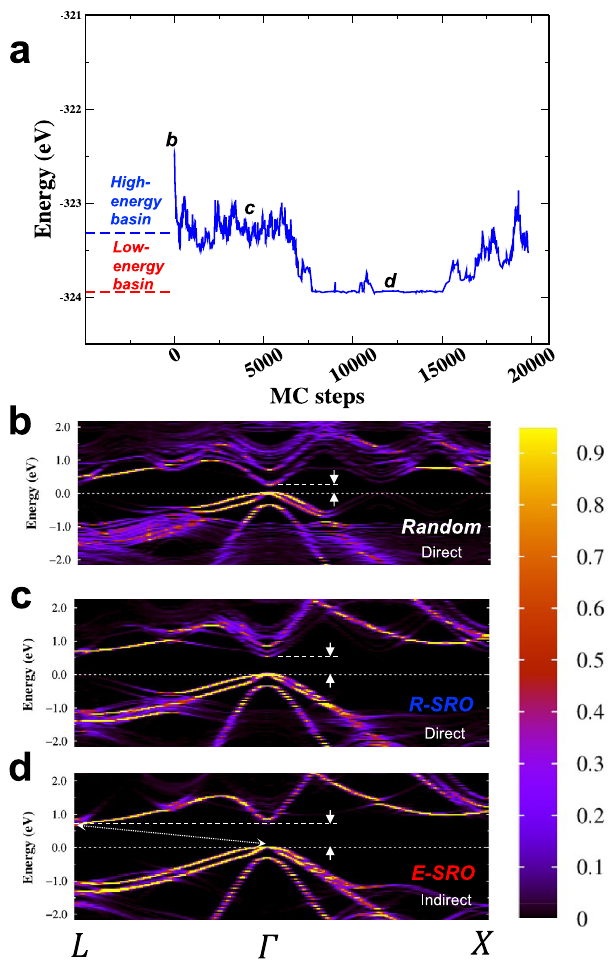
Fig. 4 Variation of the calculated electronic band structure with SRO in Si 0.125 Ge 0.625 Sn 0.25 . a Con fi gurations b – d are extracted from Monte Carlo trajectory 4 (see Fig. 1c). b A random distribution leads to a direct band gap at Γ of 0.25 eV. With R-SRO ( c ), the direct band is found to increase to 0.5 eV. d Further ordering through E-SRO yields an indirect band gap of ~0.75 eV, de fi ned by a transition between Γ and L . Band structures of alloy are calculated by unfolding the wavefunction obtained from a 128-atom cell (see “ Methods ” ) to recover the Bloch character of electronic eigenstates in the Brillouin zone of a diamond cubic lattice. The corresponding Bloch spectral weight is color coded in the bar on the